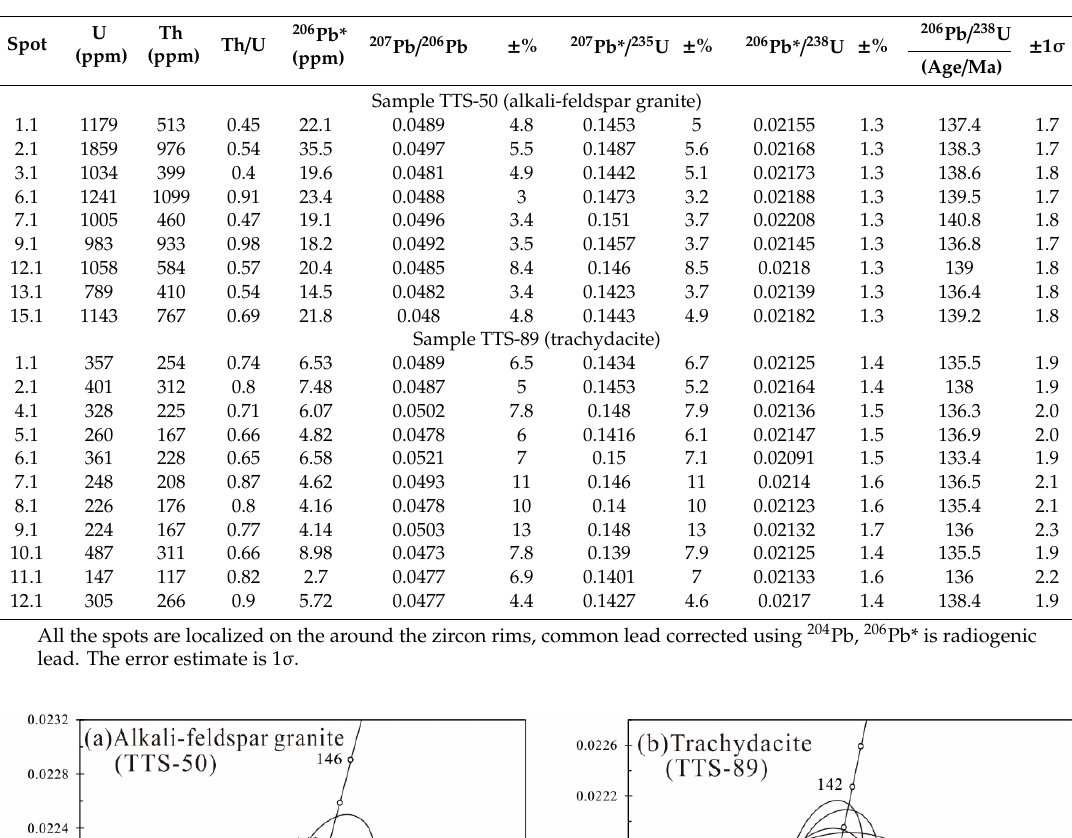
Table 1. SHRIMP zircon U–Pb dating for the Tiantangshan alkali-feldspar granite and trachydacite.